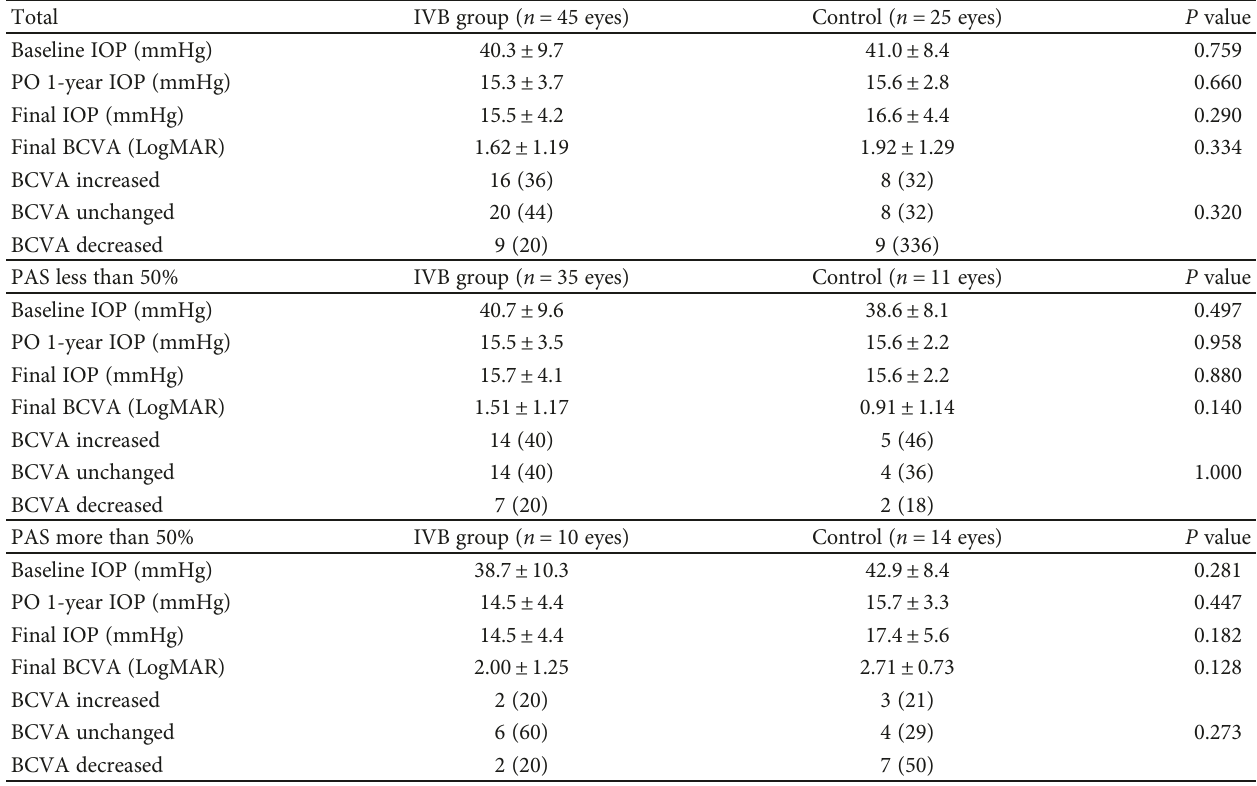
Table 2: Changes of intraocular pressure and best-corrected visual acuity after Ahmed glaucoma valve implantation in the 2 groups.